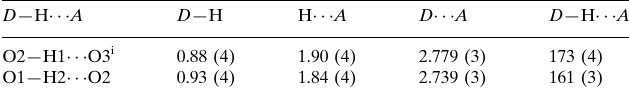
Hydrogen-bond geometry (A˚ , (cid:2)